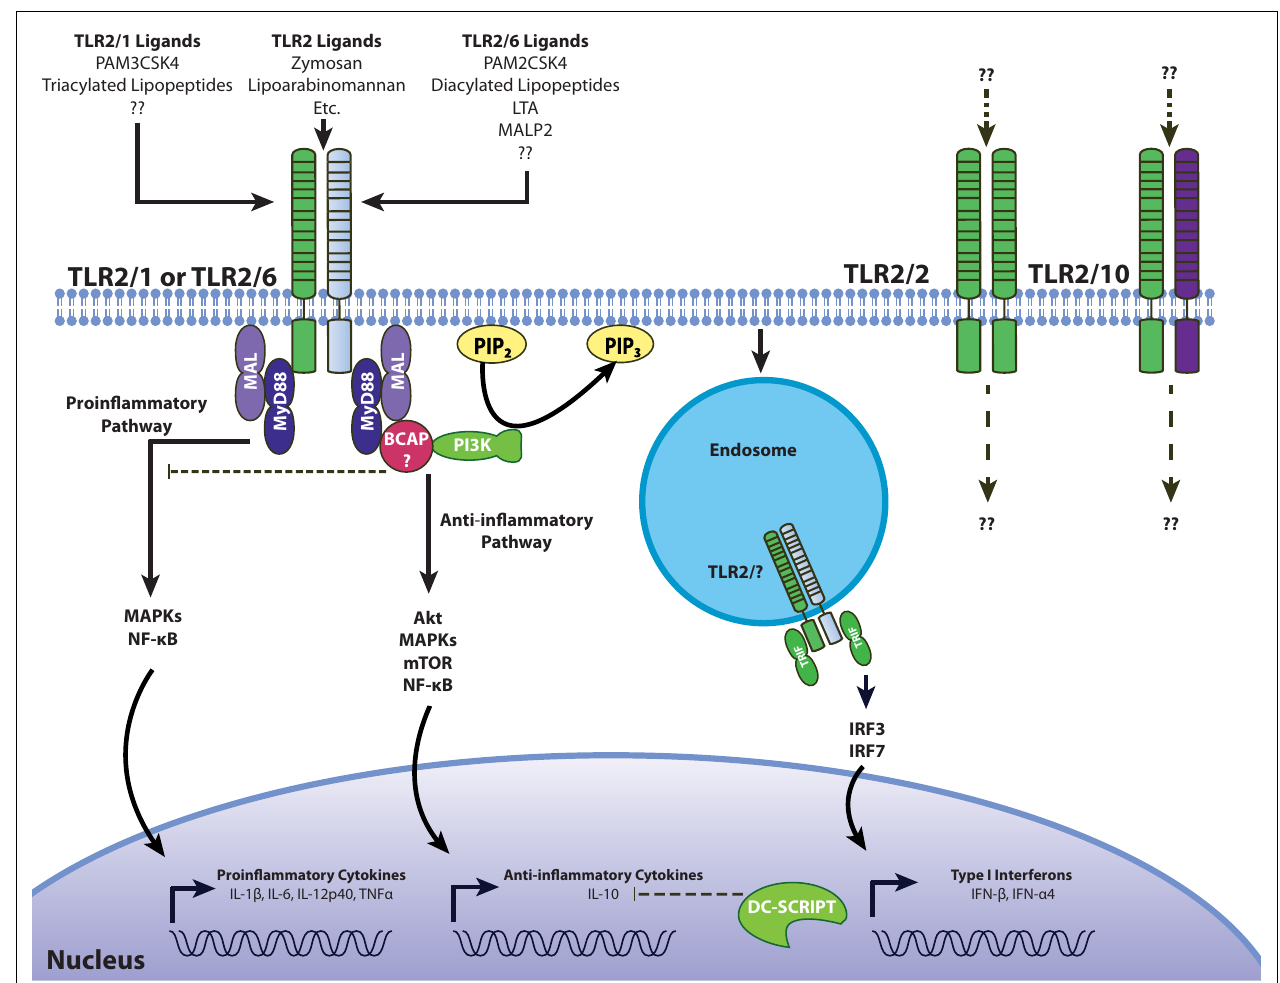
TLR2-depdendent IL-10 production has not been tested.TLR2 activation can also induce type I interferons through IRF3 and IRF7 from endosomal compartments (38, 92). Differences in signaling between theTLR2/1 and TLR2/6 heterodimers, as well the potential involvement of hypothesized TLR2/2 andTLR2/10 receptor conformations presents another challenge in understanding the plasticity ofTLR2-dependent